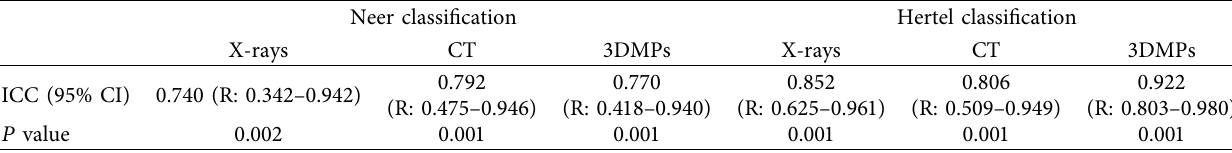
Table 2: Neer and Hertel classifications’ interobserver